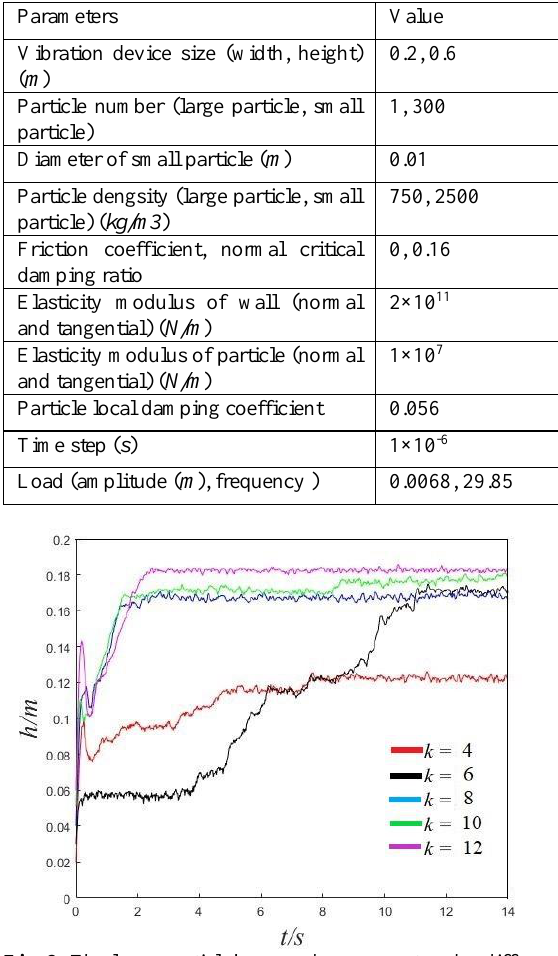
Fig. 3. The large particle's upward movement under different size ratio （ k is the size ratio ）